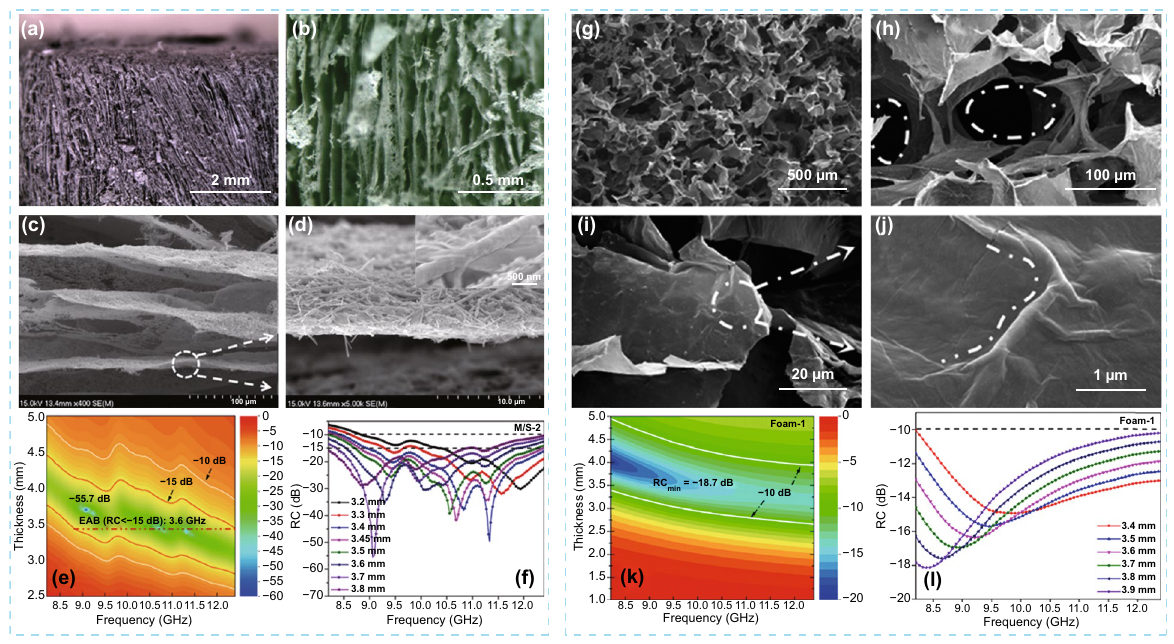
Fig. 11 a, b Digital photographs of f‑Ti 2 CT x /SiCnws hybrid foams. c, d Typical cross‑sectional SEM images of f‑Ti 2 CT x /SiCnws hybrid layers. 2D contours ( e) and RC curves ( f ) vs. frequency (8.2–12.4 GHz) and thickness (0–5 mm) of f‑Ti 2 CT x /SiCnws hybrid foam. Reproduced with permission from Ref. [156]. Copyright 2018, American Chemical Society. g‑j Typical images of f‑Ti 2 CT x /PVA foam. 2D contours k and reflec‑ tion coefficient l curves versus frequency and thickness of f‑Ti 2 CT x /PVA foams. Reproduced with permission from Ref. [100]. Copyright